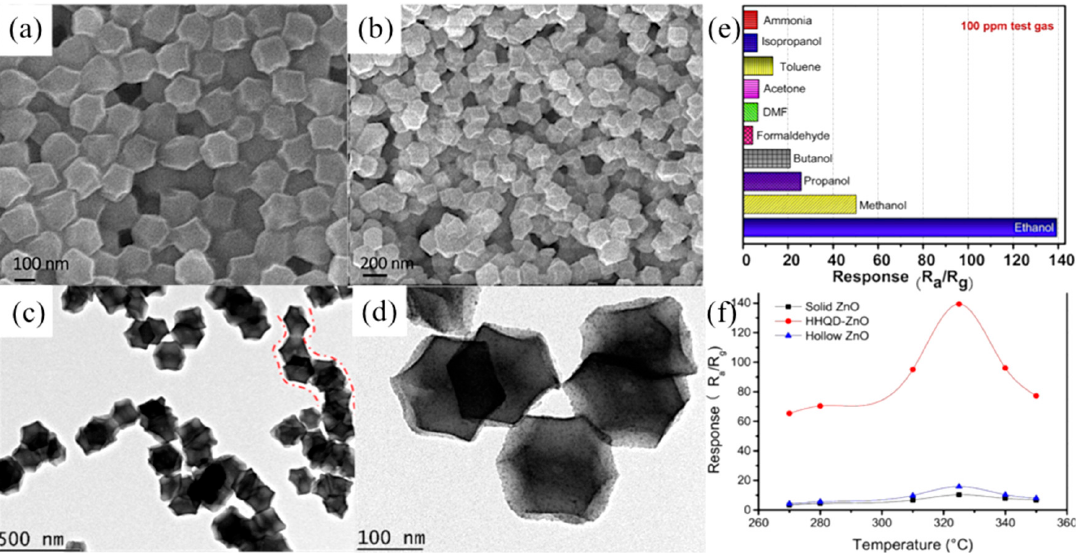
Figure 5. SEM and TEM images of ( a , c ) the 170-ZIF-8 precursor and ( b , d ) the as-derived HHQD-ZnO nanocage; ( e ) Response of HHQD-ZnO nanocages-based gas sensor toward 100 ppm different target gases (ammonia, formaldehyde, dimethylformamide, acetone, toluene, isopropanol, methanol, propanol, butanol and ethanol, respectively); ( f ) Responses of the sensors based on HHQD-ZnO, hollow ZnO and solid ZnO to 100 ppm ethanol gas at different operating temperatures [80].